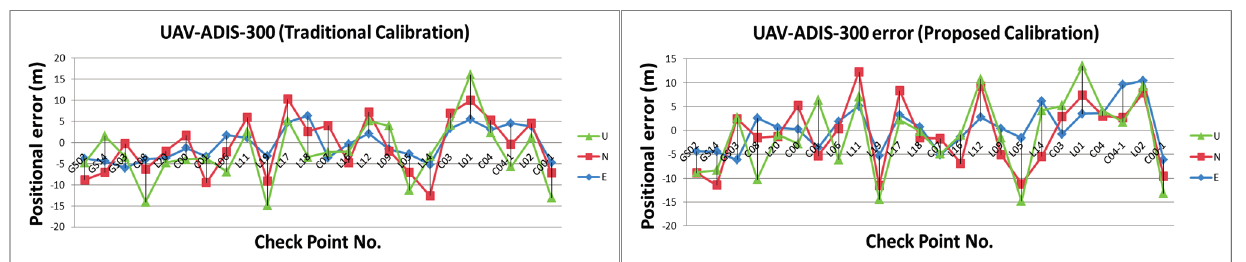
Figure 26. DG error based on ADIS 16488 with 600 m.